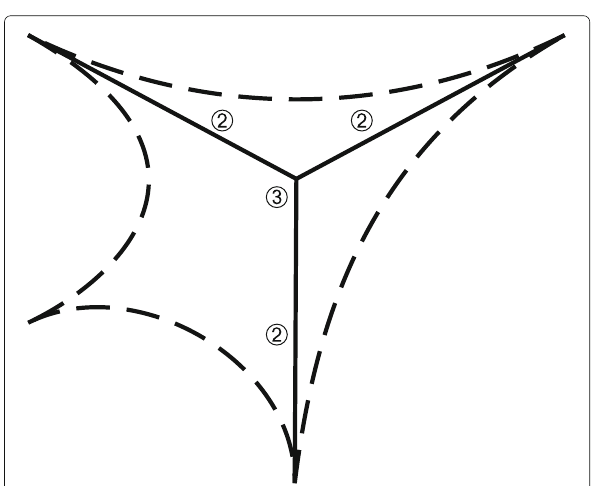
Fig. 6 Example of cut locus on S 2 . Simplebranch : two intersecting minimizers, Ramificationpoint: three intersecting minimizers. Conjugatelocus: dashed